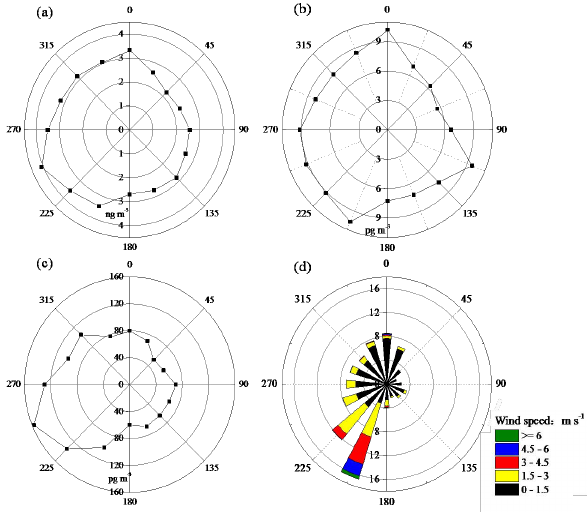
Fig. 5. Statistics of (a) average GEM concentration, (b) average RGM concentration, (c) average PBM concentration and (d) wind direction frequency in different wind